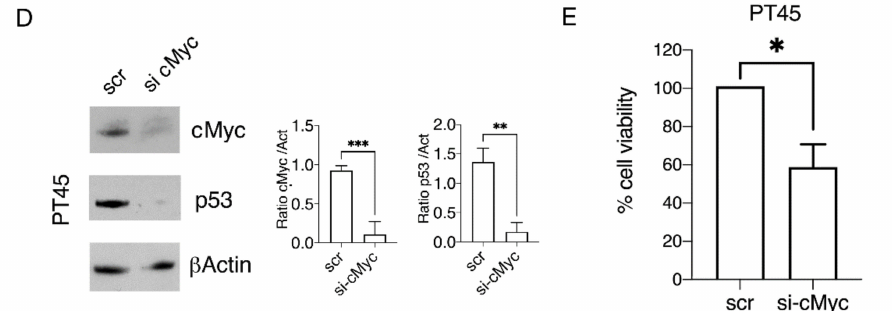
Figure 1. c-Myc inhibition impairs pancreatic cell survival in correlation with mutp53 downregula- tion. Pancreatic cell lines (PaCa44 and PT45) were treated with two different doses of c-Myc inhibitor (i-cMyc) for 48 h. ( A ) Cell survival was evaluated by trypan blue exclusion assay. The histograms represent the mean plus SD of live cells as percentage of untreated control cells, p value: * <0.05; ** <0.01; **** <0.0001; to evaluate cell death ( B ) PARP expression was evaluated by Western blot analy- ses. β Actin was used as loading control and one representative experiment is shown. The histograms represent the mean ± SD of densitometric analysis of the ratio of PARP cl/Act. p value: **** <0.0001; ( C ) p53 expression was evaluated by Western blot analyses. β Actin was used as loading control and one representative experiment is shown. The histograms represent the mean ± SD of densitometric analysis of the ratio of p53/Act. p value: *** <0.001; to evaluate the role of c-Myc in p53 downregu- lation, PT45 cells were transfected for 48 with cMyc silencing (si cMyc) and control siRNA-A (scr) as control ( D ) protein expression of c-Myc and p53 was evaluated by Western blot analyses. β Actin was used as loading control and one representative experiment is shown. The histograms represent the mean ± SD of densitometric analysis of the ratio of cMyc/Act and p53/Act. p value: ** <0.01; *** <0.001; ( E ) Cell survival after 48 h of transfection was evaluated by trypan blue exclusion assay. The histograms represent the mean plus SD of live cells as percentage of control cells, p value: *